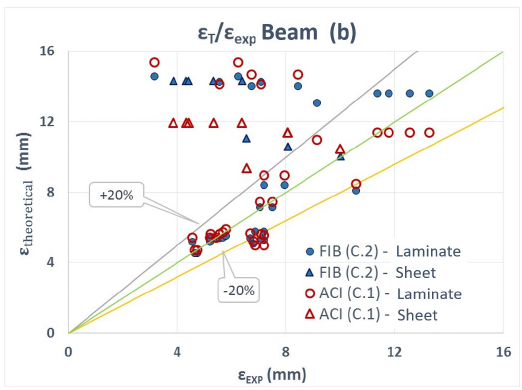
Figure 3. ACI440 x FIB - Analysis of the ultimate strain ( / theoretical exp   ) for beam